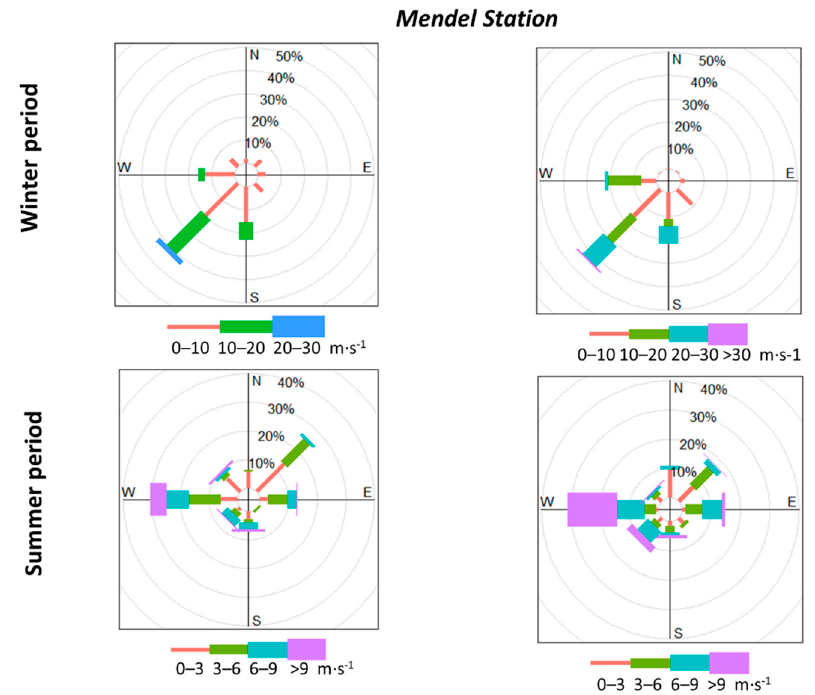
Figure 6. Wind roses showing observed and modelled wind speed and direction for the summer and winter periods at Davies Dome and Mendel Station.